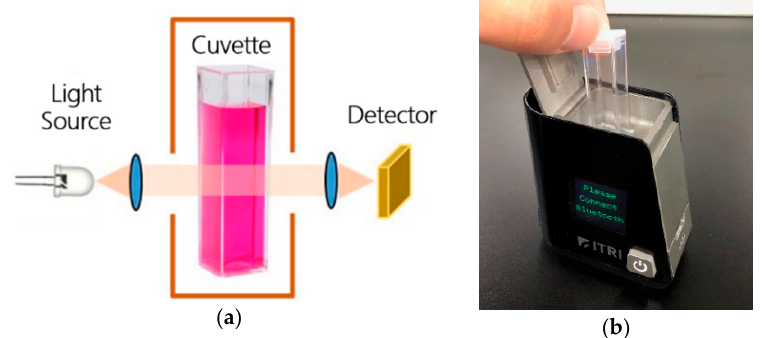
Figure 1. Bacterial colorimetric device module design and development: ( a ) transmissive optical setup schematic and ( b ) a real image of the device.